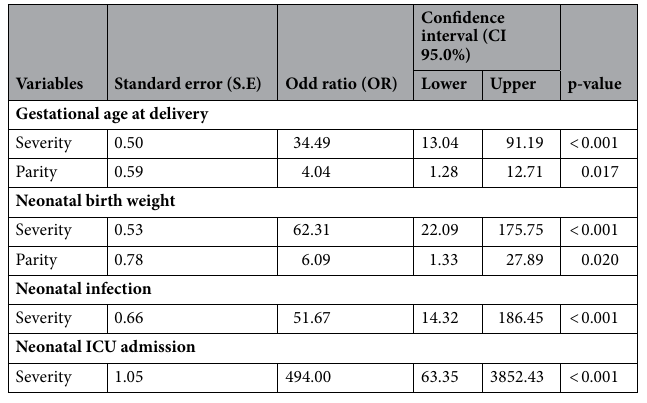
Variables Standard error (S.E) Odd ratio